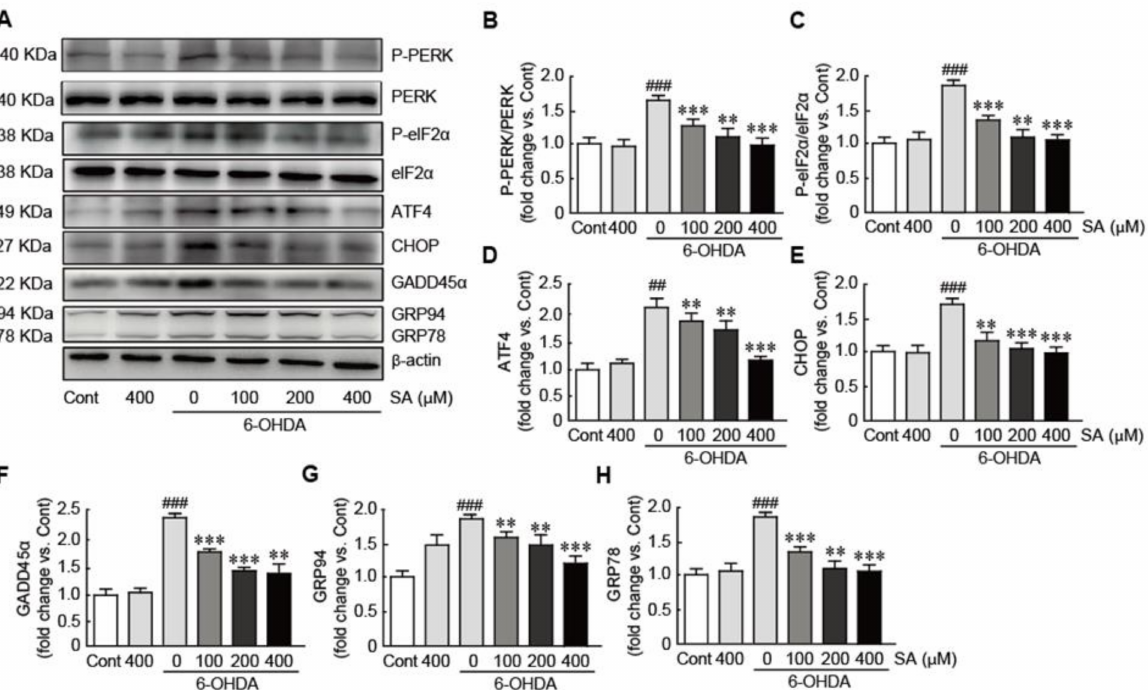
Figure 6. SA prevents ER stress caused by 6-OHDA-induced neurotoxicity in SH-SY5Y neuroblastoma cells. ( A ) Western blot analyses were performed to measure the expression levels of ER-stress-related proteins in SA-pretreated/6-OHDA-treated cells. The expression levels of total and phospho-PERK ( B ), total and phospho-eIF2 α ( C ), ATF4 ( D ), CHOP ( E ), GADD45 α ( F ), GRP94 ( G ), and GRP78 ( H ) proteins were quantified using HD imaging software. β -actin was used as the loading control. Western blot analysis was performed in triplicate with three independent samples. Data are shown as the mean ± standard error of the mean (SEM). Significance was determined via a one-way ANOVA with a Bonferroni post hoc test. ## p < 0.01 and ### p < 0.001 vs. control group. ** p < 0.01 and *** p < 0.001 vs. the 6-OHDA-only-treated group. Cont, control; SA, sinapic acid; 6-OHDA, 6-hydroxydopamine; PERK, pancreatic ER kinase; eIF2 α , eukaryotic translation initiation factor 2 α ; ATF4, activating transcription factor 4; CHOP, C/EBP homologous protein; GADD45 α , growth